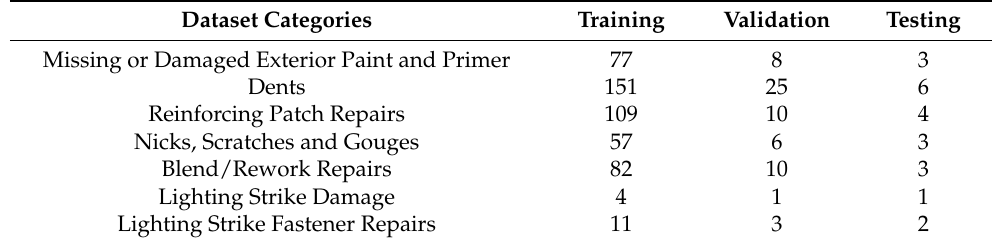
Table 2. Dataset split for training, validating and testing the defect